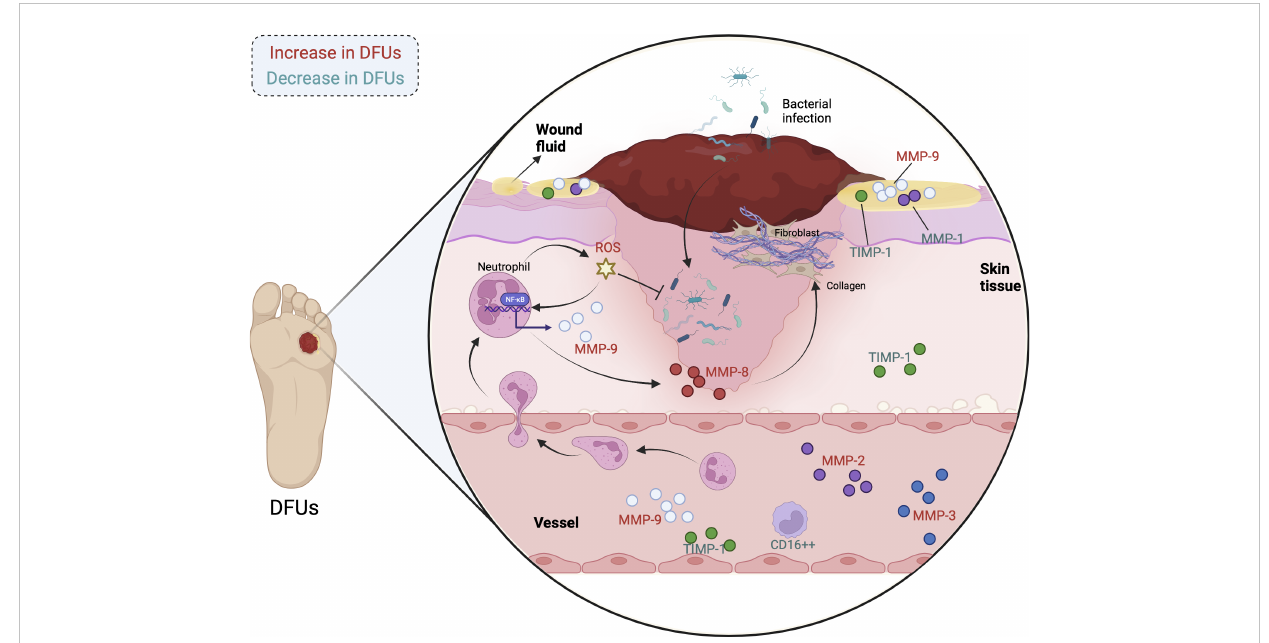
FIGURE 2 The changes of MMPs levels in individuals with diabetic ulcers. (MMPs are in fl uential regulators in DFUs, whose expressions are diverse in the wound fl uid, skin tissue, and blood of patients. The correlations have been observed between MMPs and physiological as well as pathological processes of DFUs, involving COL deposition, in fl ammatory response, oxidative stress, and bacterial infection. The MMPs in red are increased in individuals with DFUs, while the MMPs in green are decreased in individuals with